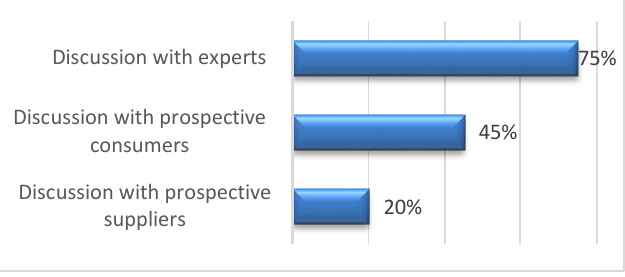
Figure 9: Resources for Market Research ; Source: Author